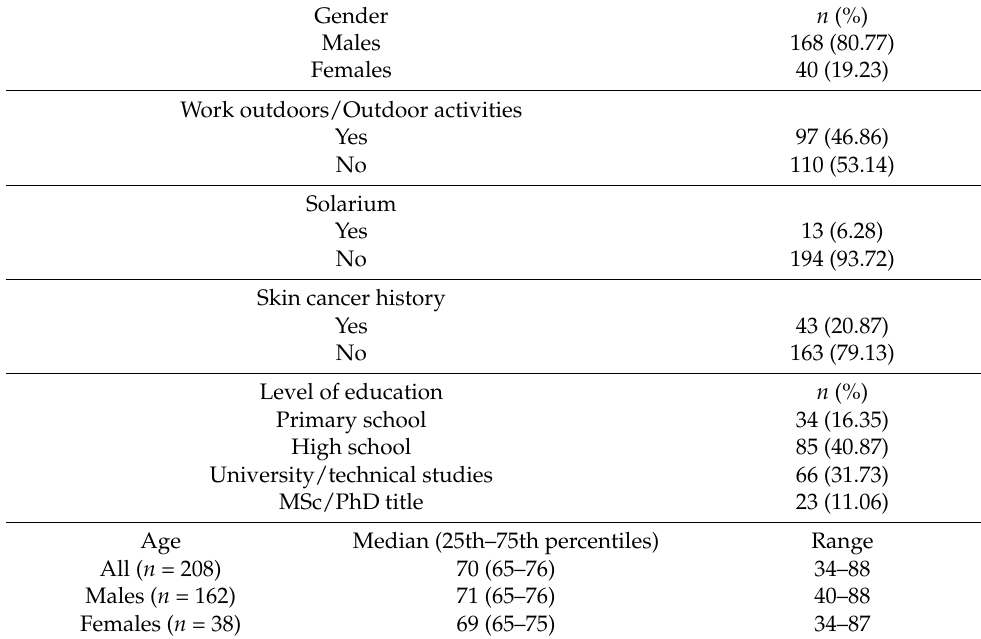
Table 1. Patients’ demographics and